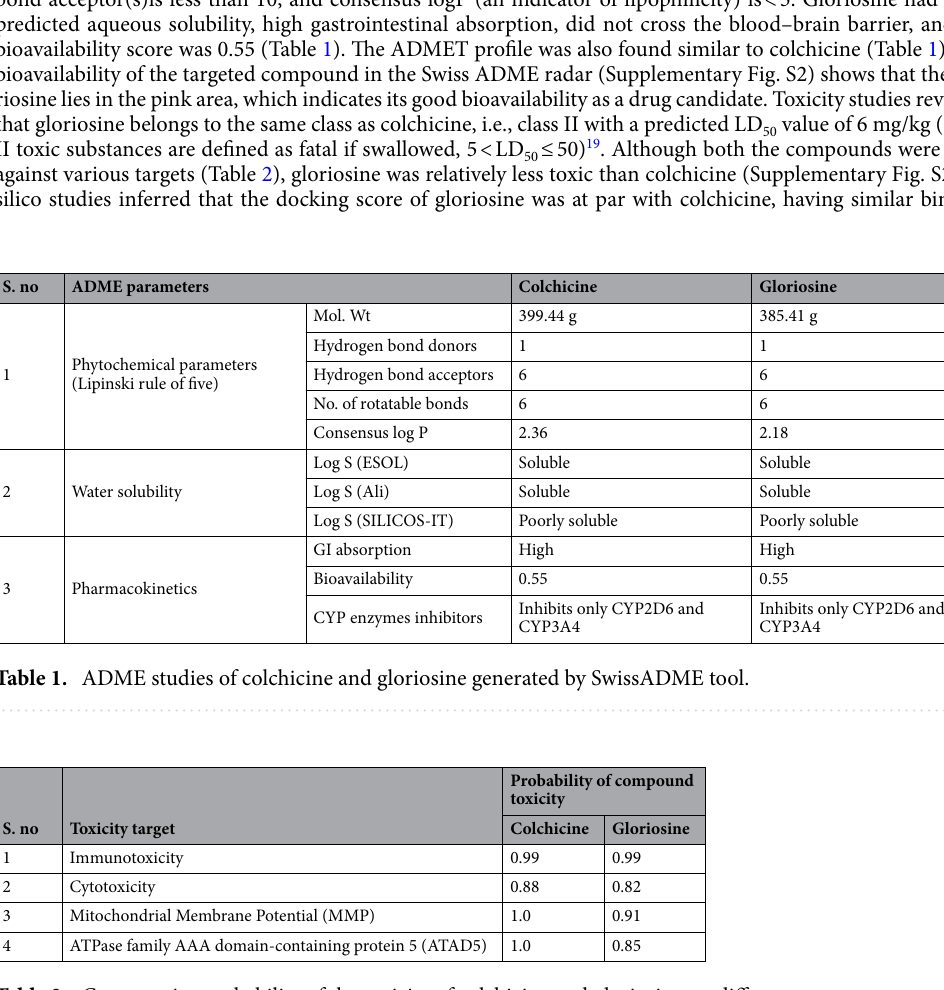
Table 2. Comparative probability of the toxicity of colchicine and gloriosine on different targets generated by Protox II.